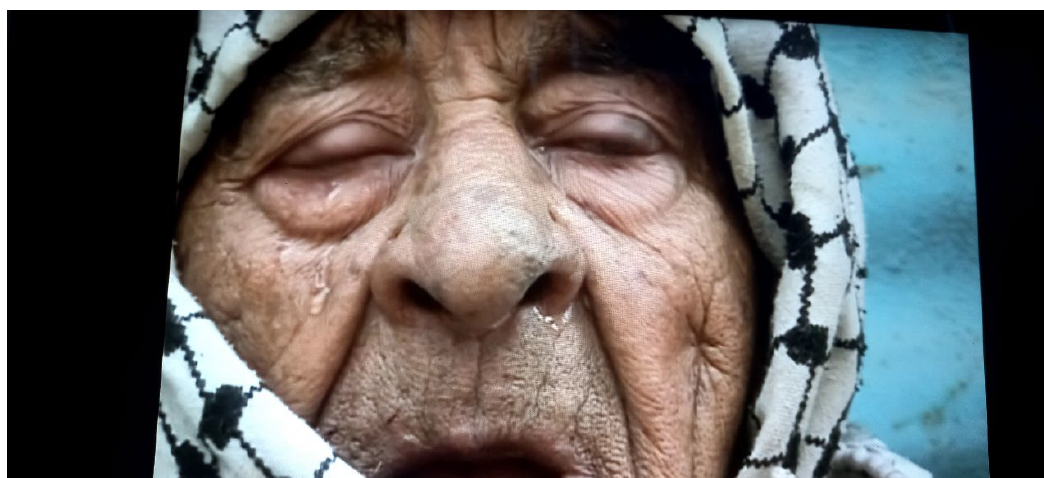
Figure 14 Yousuf right before evacuation, Source: 'Roshmia', Salim Abu-Jabel,